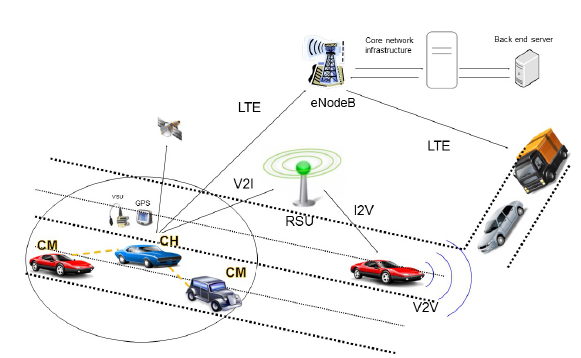
Figure 3. Data dissemination in VANETs